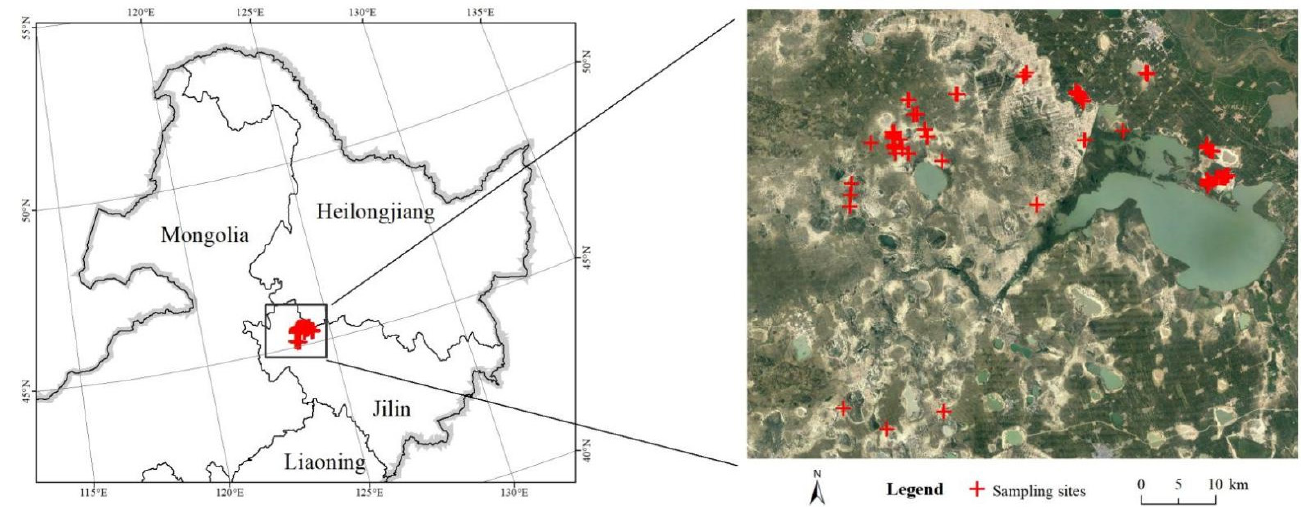
Figure 1. This study area and sampling points located on a Landsat-8 satellite image.